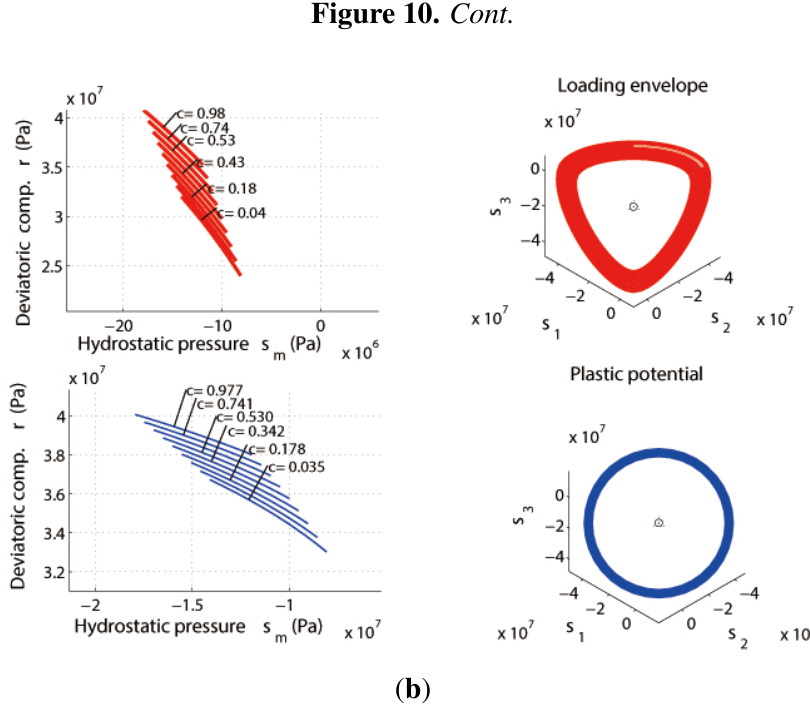
Figure 11. Hardening and softening stages in numerical triaxial compression test. ( a ) Hardening; ( b )